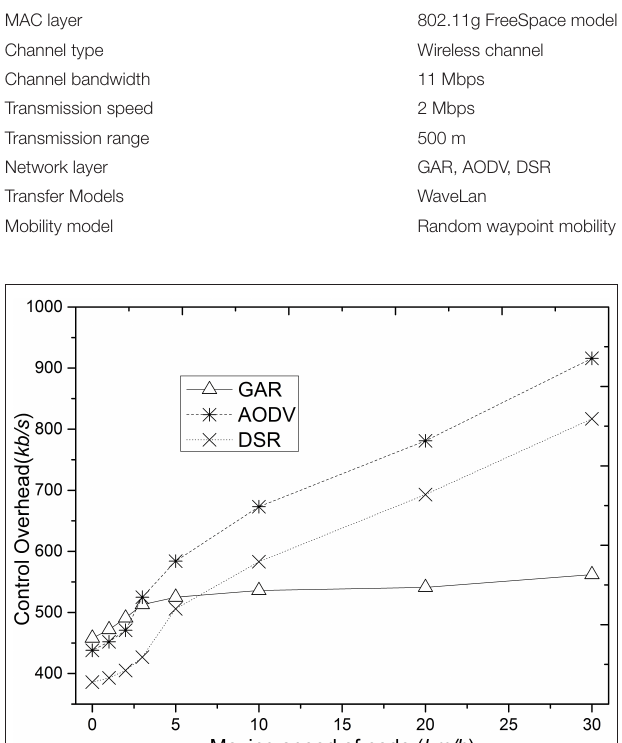
FIGURE 3 | Comparison of control overhead as node speed